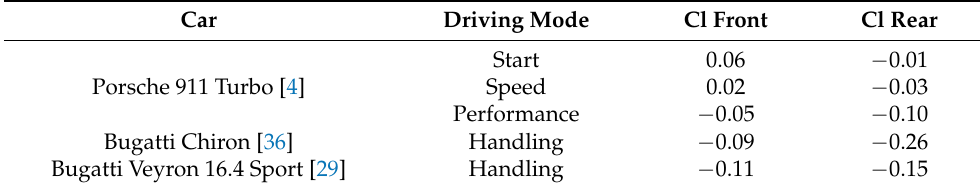
Table 6. Load distribution of the lift coefficient (Cl) for different sports cars. Car Driving Mode Cl